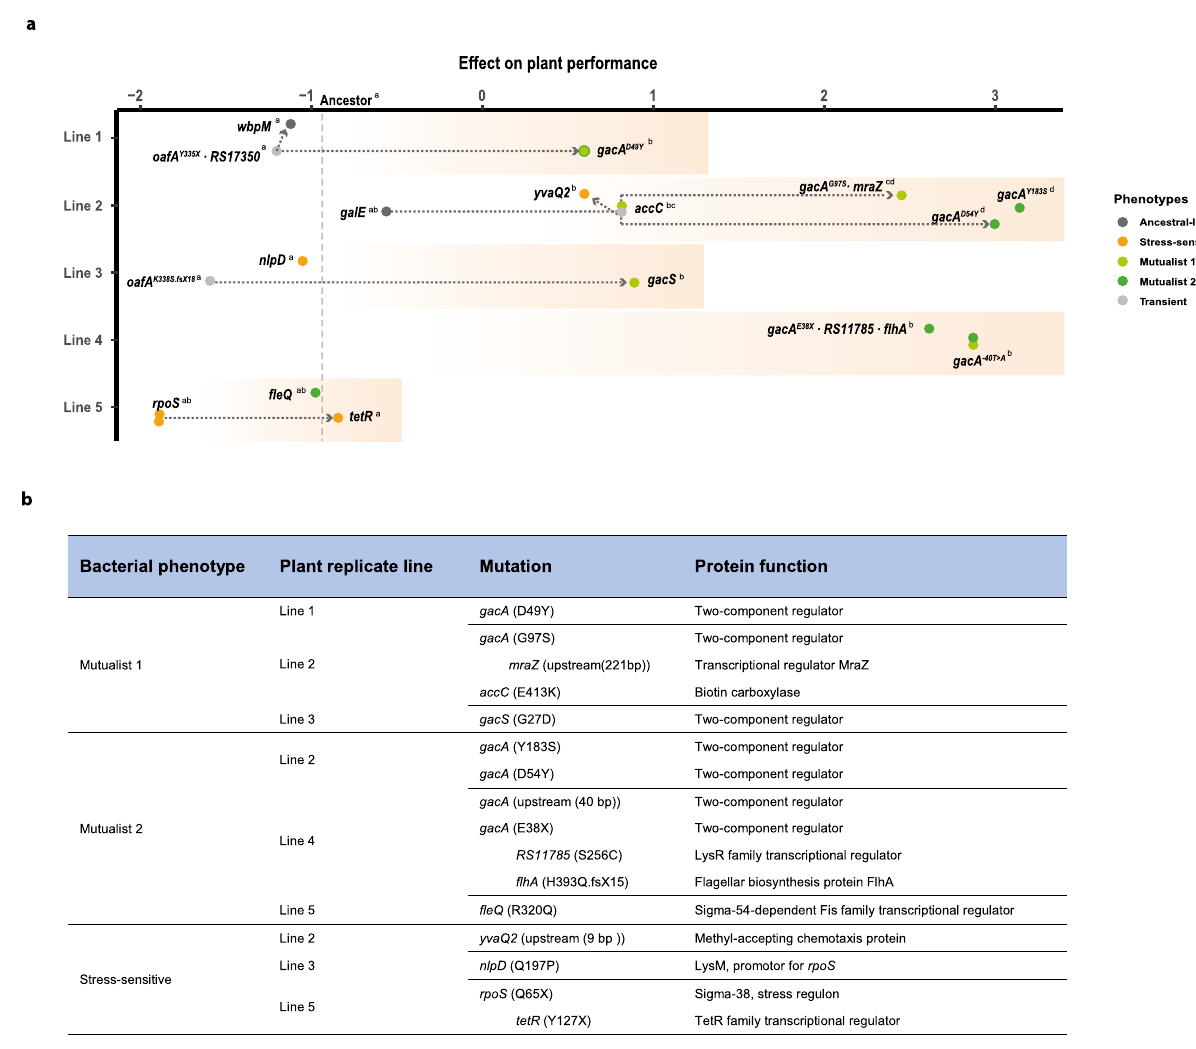
Fig. 4 Genetic basis of bacterial evolution in the rhizosphere of Arabidopsis thaliana . Panel a shows clear parallel evolution between four out of fi ve plant replicate selection lines based on re-sequencing of 25 evolved and fi ve ancestor isolates used in the phenotypic assays. Filled dots represent isolates with novel mutations (present in 18/25 evolved isolates). The seven isolates without mutations, or only synonymous mutations, are not included. The x -axis shows a combined index of ‘ Plant performance ’ relative to non-inoculated control plants (values on the x -axis indicate positive and negative effects on the plant and the y -axis shows the fi ve independent plant replicate selection lines). The effect of the ancestral bacterial genotype on plant performance is shown as a vertical dashed line. Statistical testing in panel a was carried out using one-way ANOVA (each line analysed separately). The different letters on the top right of each genotype indicate signi fi cant differences based on a Tukey's HSD test ( α = 0.05; each line analysed separately, n = 3). Bacterial phenotype groups are displayed on different colours (black: ancestor; dark grey: ancestral-like; light grey: transient; orange: stress-sensitive, light green: Mutualist 1 and dark green: Mutualist 2) and the accumulation of mutations within replicate lines are shown with connected dashed arrows. Panel b table lists unique mutations linked with evolved bacterial phenotypes. Successive mutations that appeared within the same genetic background are shown after the indent. Notably, these additional mutations did not affect the bacterial phenotypes (see Table S3 for a more detailed description of the mutations). Data for all panels are provided in the Source Data fi